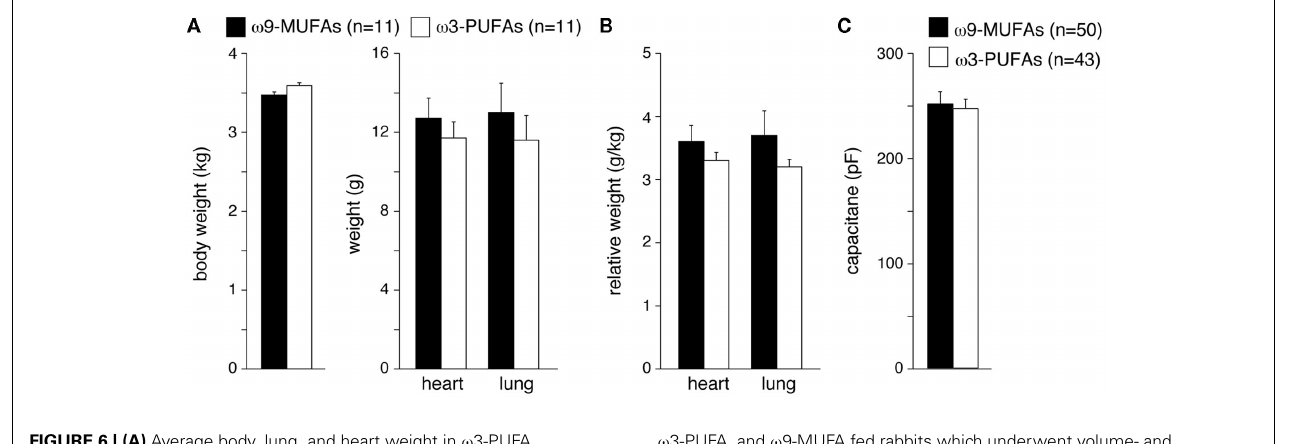
FIGURE 6 | (A) Average body, lung, and heart weight in ω 3-PUFA and ω 9-MUFA fed rabbits which underwent volume- and pressure-overload. n , Number of rabbits (B) , Relative lung weight and relative heart weight, an index of cardiac hypertrophy, in